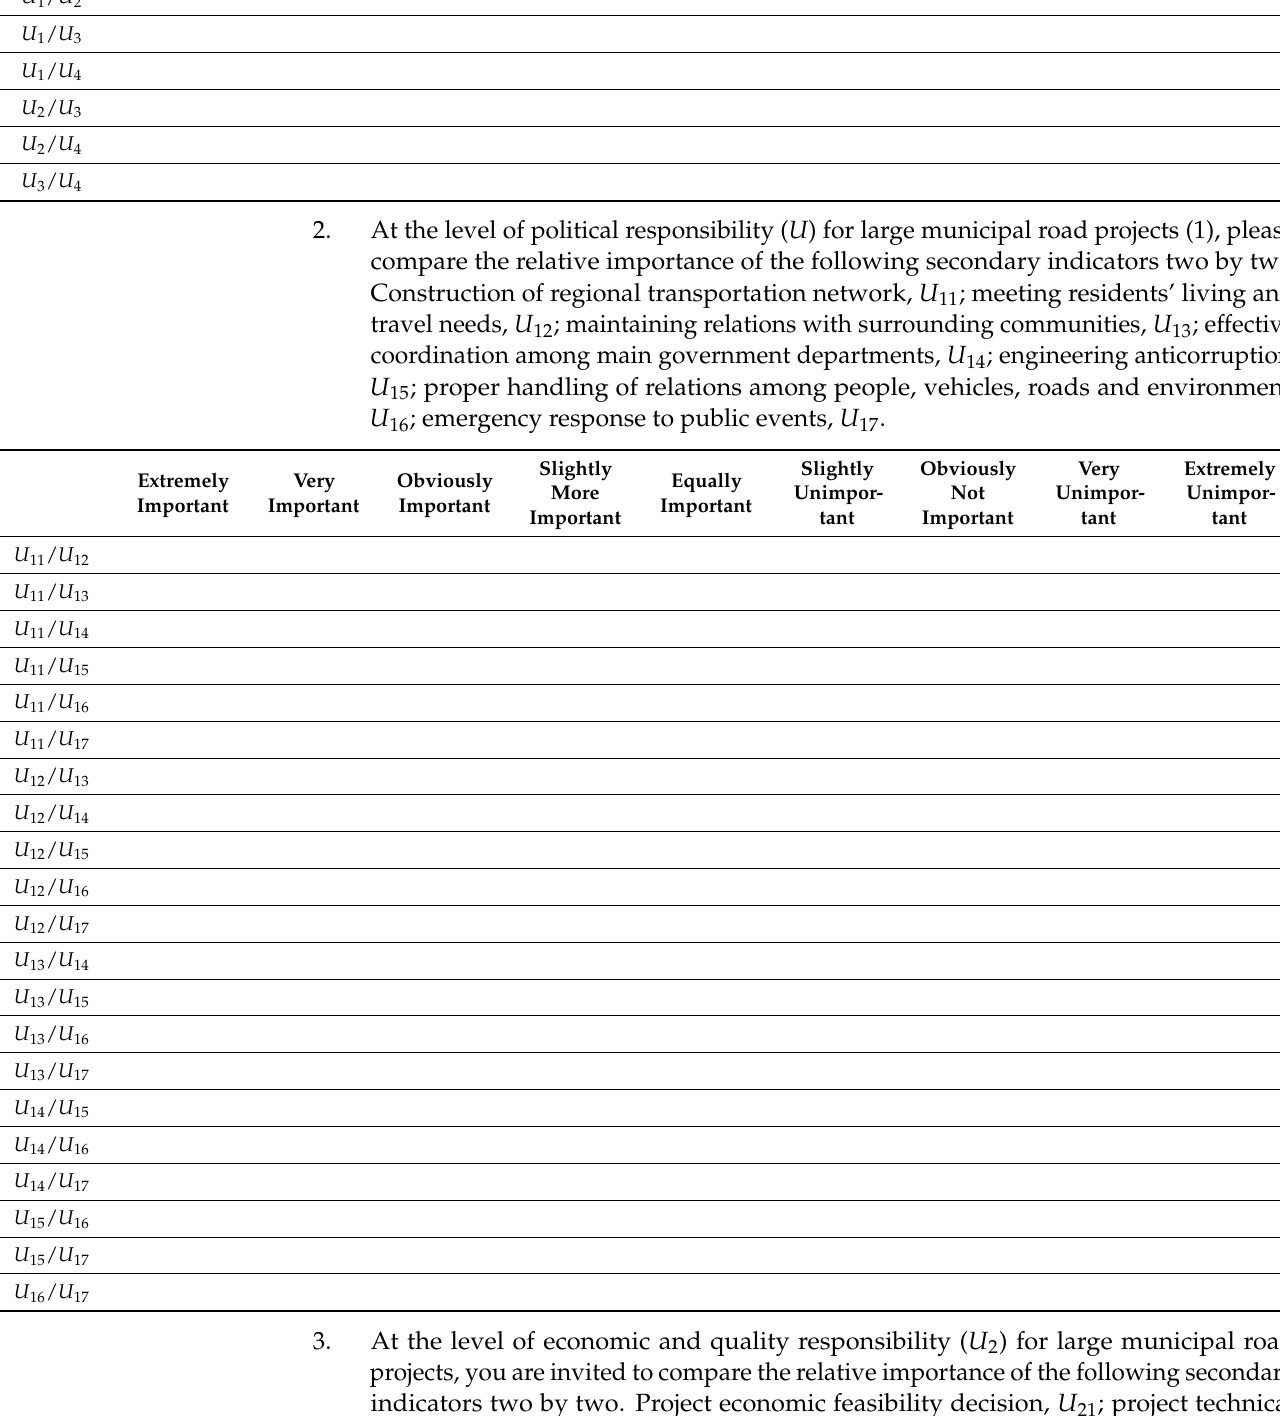
At the level of economic and quality responsibility ( U 2 ) for large municipal road projects, you are invited to compare the relative importance of the following secondary indicators two by two. Project economic feasibility decision, U 21 ; project technical feasibility decision, U 22 ; perfect project governance mechanism, U 23 ; road